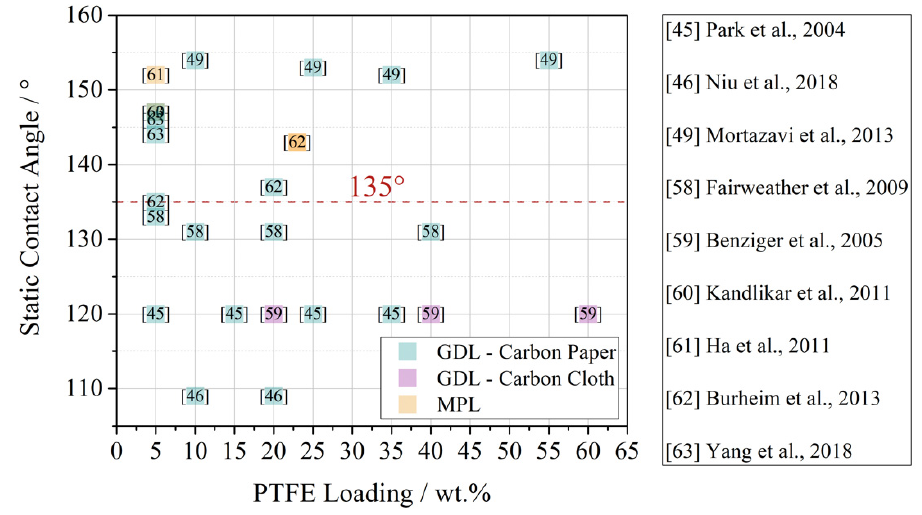
Figure 5. Static contact angle values measured for GDLs with different PTFE loadings